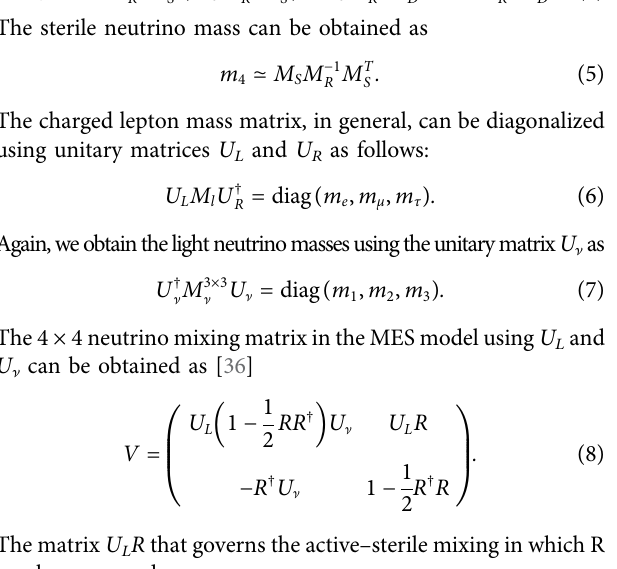
TABLE 3 | Fields and their respective transformations under the symmetry group of the model. Here, ω (cid:2) e i 2 π /3 and ω ̄ (cid:2) e − i 2 π /3 are the complex roots of unity.